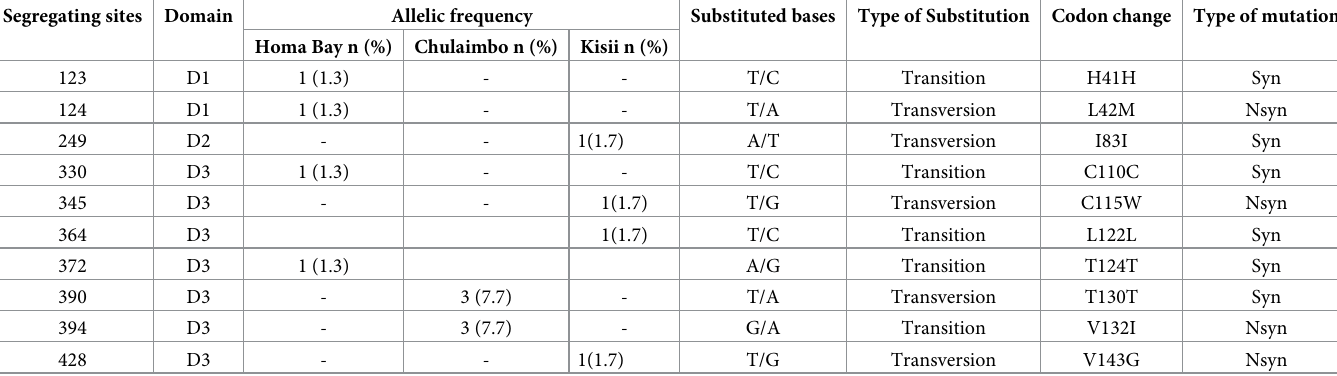
Table 1. Polymorphic sites in Pfs25 sequences from Homa Bay, Kisumu (Chulaimbo) and Kisii region in western Kenya. Segregating sites